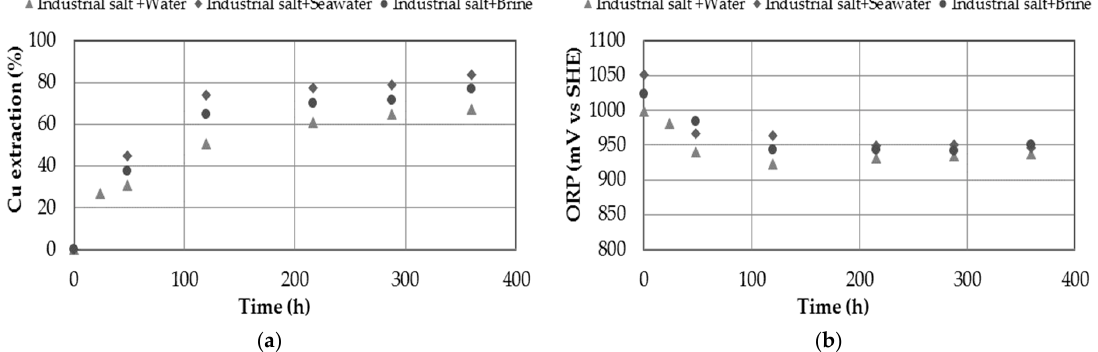
Figure 11. ( a ) Copper extraction (%) vs. time (h) when di ff erent sources of water were used with industrial salt. ( b ) Redox potential (mV) vs. time (h) when di ff erent sources of water were used with industrial salt. Experimental conditions: [NaNO 3 ] = [H 2 SO 4 ] = 0.7 M, 45 ◦ C and sample